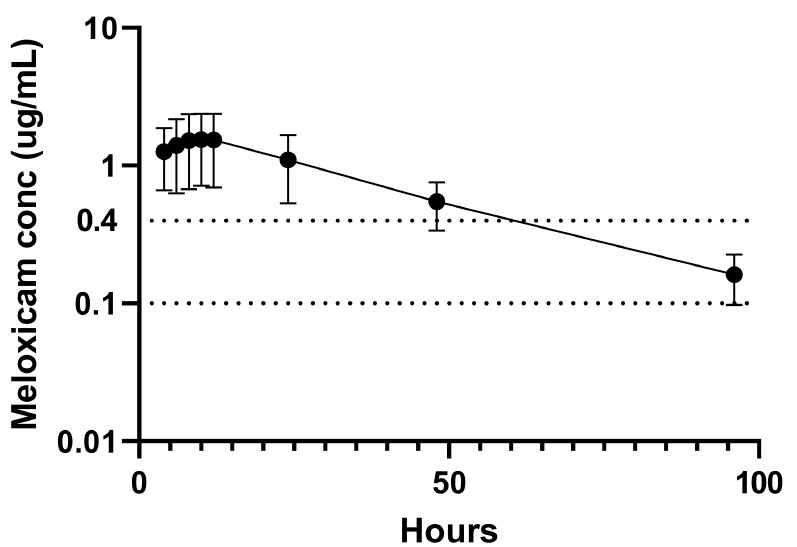
Figure 1. Plasma concentrations (ug/mL) of 2 mg/kg sustained-release meloxicam formulation (SRMF) following subcutaneous administration in sheep ( n = 6) over 96 h. The dotted line at y = 0.1 µ g/mL is the lower limit of quantification of the assay [12]. The dotted line at y = 0.4 µ g/mL is a theoretical plasma analgesic concentration.